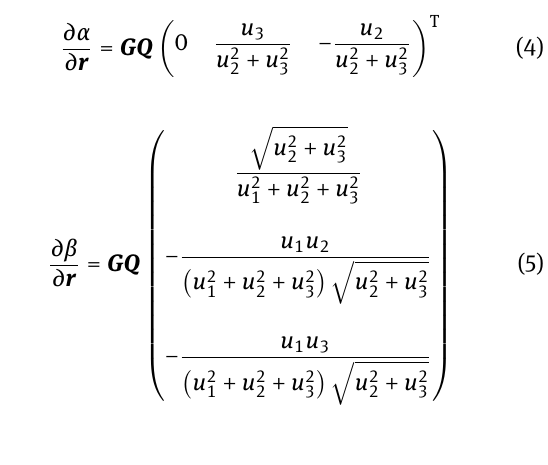
Figure 1. Relationship between UEN and ECF